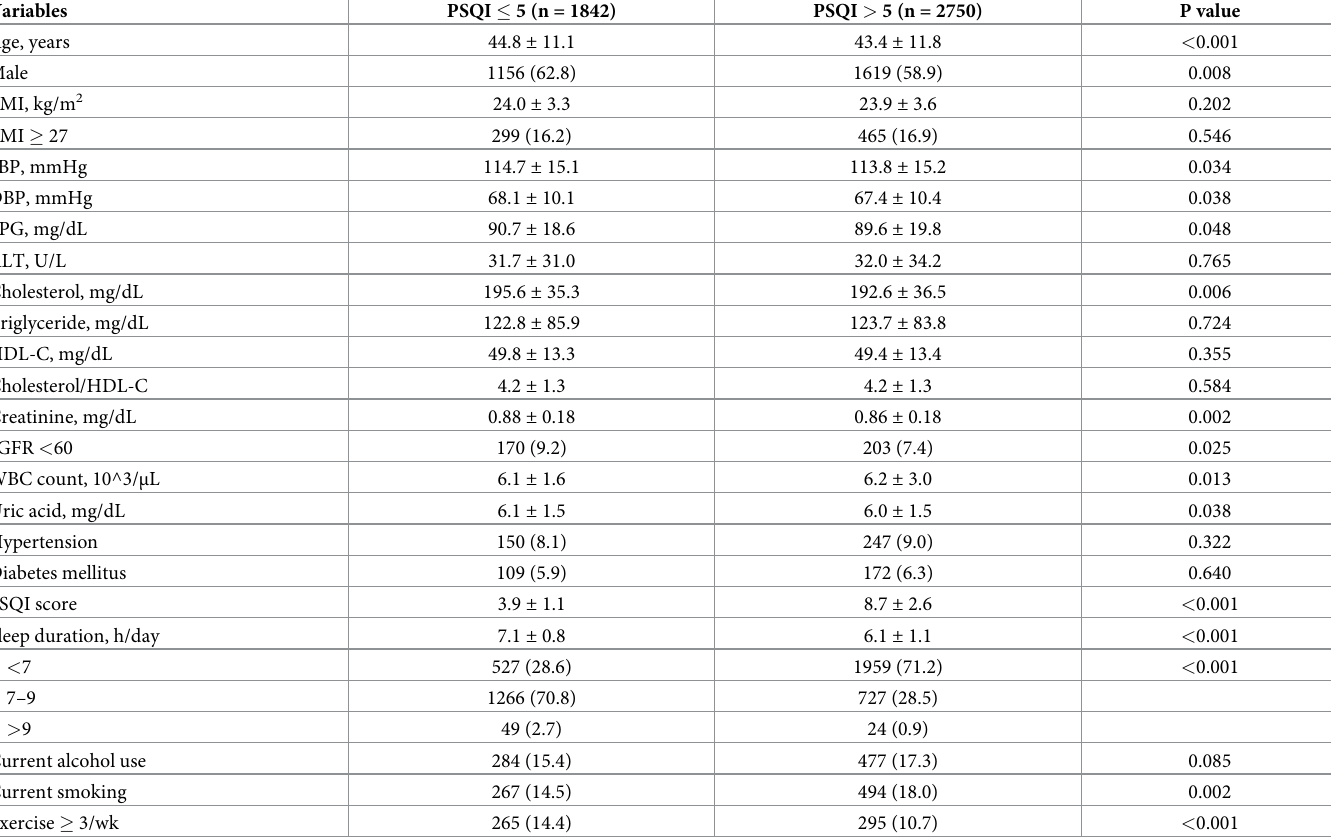
Table 1. Comparisons of participants’ clinical characteristics based on sleep quality.